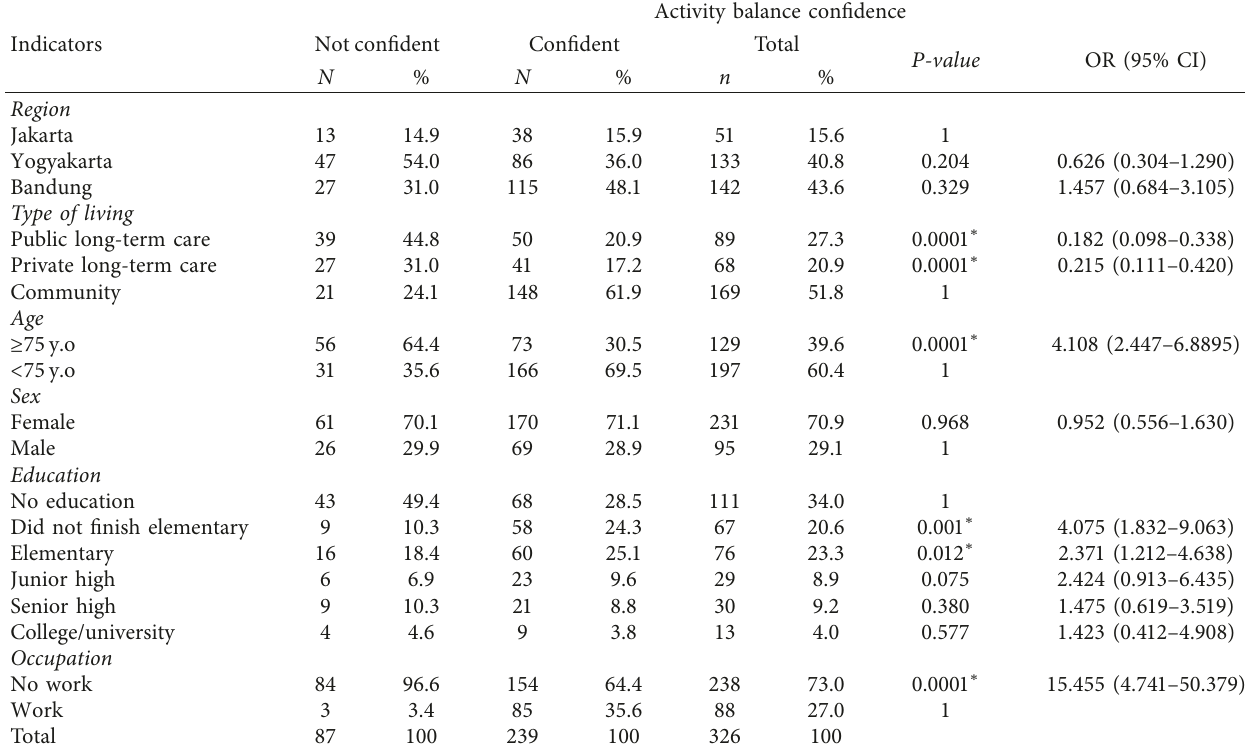
Table 2: Balance confidence and demographic